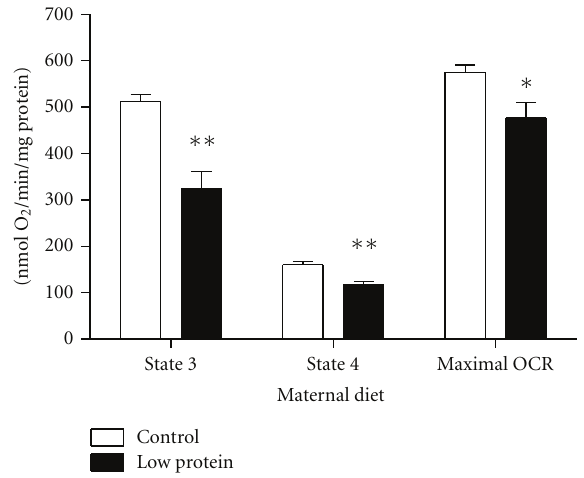
Figure 1: Respiration rates in mitochondria from rat kidney. Res- piration rates in state 3, state 4 and maximal respiration rates were determined in isolated mitochondria using an oxygen electrode. Duplicate measurements were performed on each preparation and averaged. Values are means ± S.E.M. from 5 independent preparations for each group. ∗ , ∗∗ P < 0 . 05, P < 0 . 01 compared with controls in the same